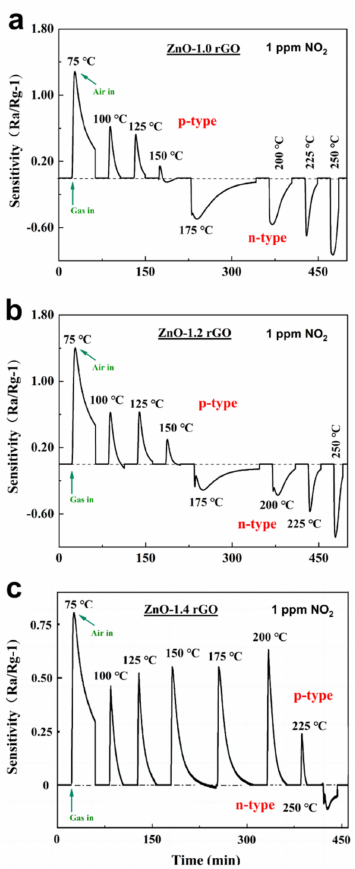
Figure 8. Dynamic sensing transients of ( a ) ZnO-0.6% rGO and ( b ) ZnO-0.8% rGO at 4 ppm to 30 − 225 ◦ C.